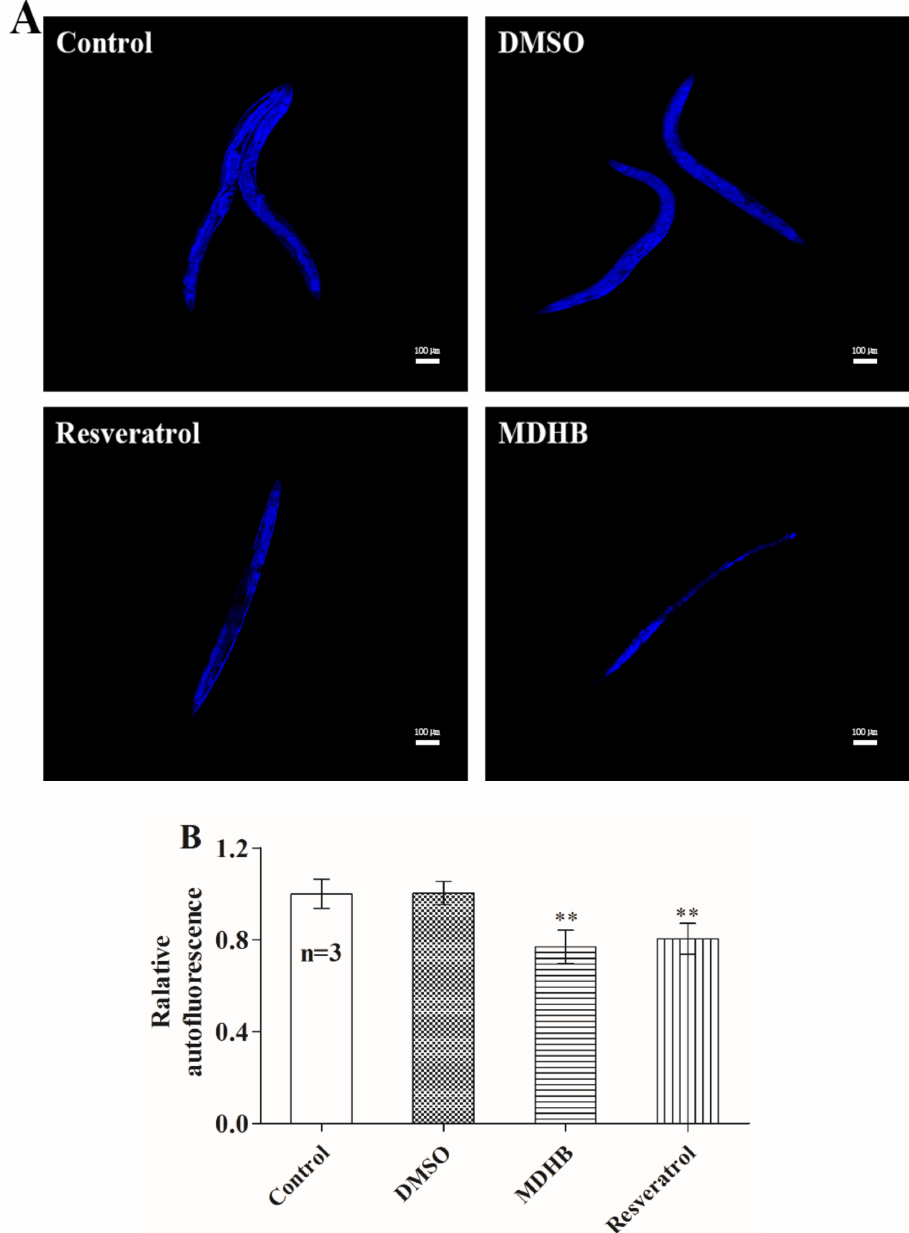
Figure 2. Effect of MDHB on lipofuscin accumulation of wild-type C. elegans . ( A ) Typical fluorescence images of worms in untreated control, Dimethyl sulfoxide (DMSO)-treated, resveratrol-treated and MDHB-treated worms are shown. ( B ) Effect of MDHB on intracellular lipofuscin accumulation in wild-type C. elegans at day 10. Fluorescence intensities of the lipofuscin fluorescence of 30 worms from different groups were analyzed by the ImageJ soft. Data are shown as means ± S.E.M comparing to the untreated control (OD-background/mm 2 = 465.32 ± 31.56; set to 1). Statistical significance of differences between treated and control groups were described significant at ** p < 0.01 by one-way ANOVA with LSD post hoc test. ANOVA, analysis of variance. This experiment was performed three